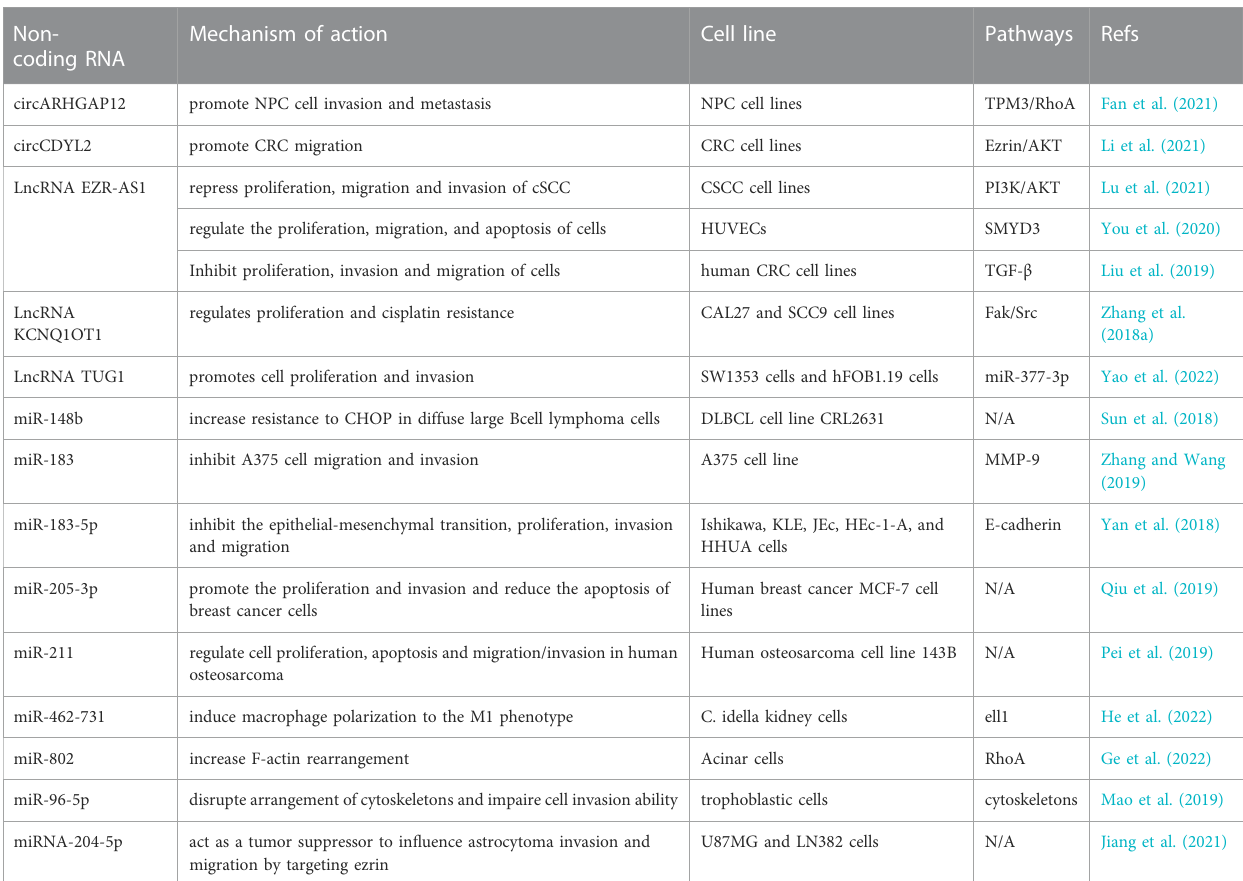
TABLE 1 The post-transcriptional regulation of